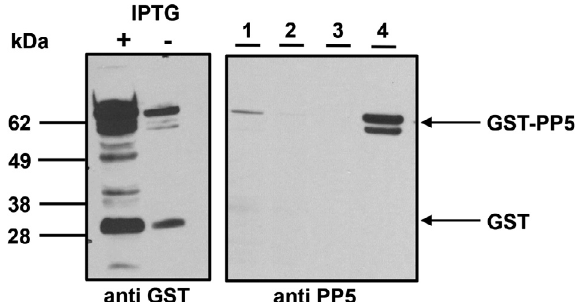
Figure 3. Expression of GST-PP5 in BL-21 cells. Expression of GST-PP5 as detected by Western blotting using an anti-GST antibody (left panel) induced with 0.1 mM IPTG or uninduced. Right panel, polyclonal anti-PP5 antibody. Lanes are representative of the elution process: total protein lysate (lane 1), flow through washes (lanes 2 and 3) and GST-PP5 protein eluate (lane 4). The molecular weight of standard proteins is indicated in kDa.